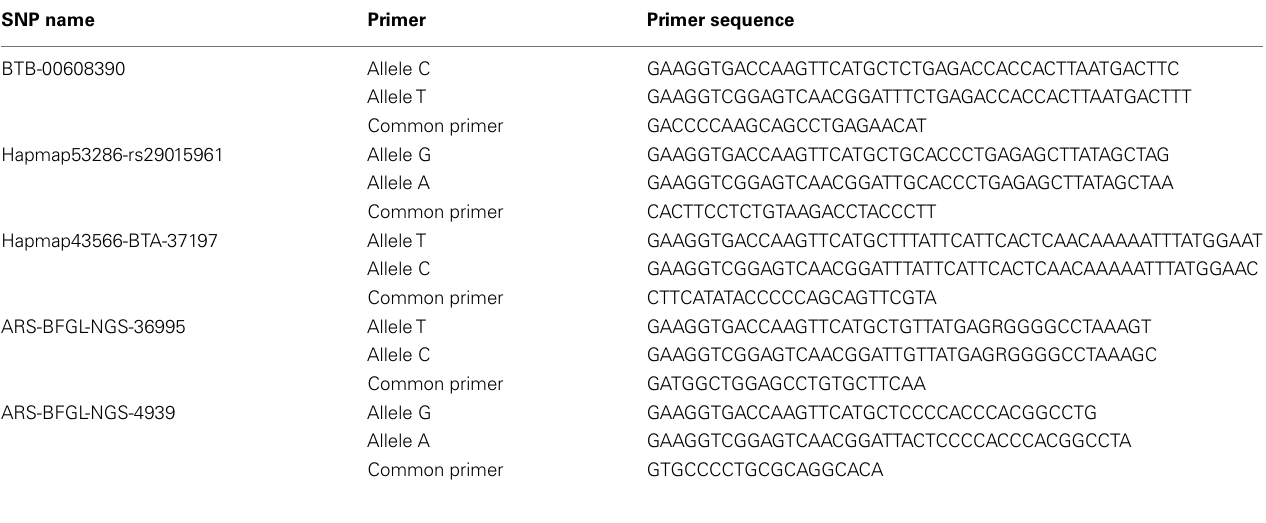
Table 1 | Primer sequences for SNP